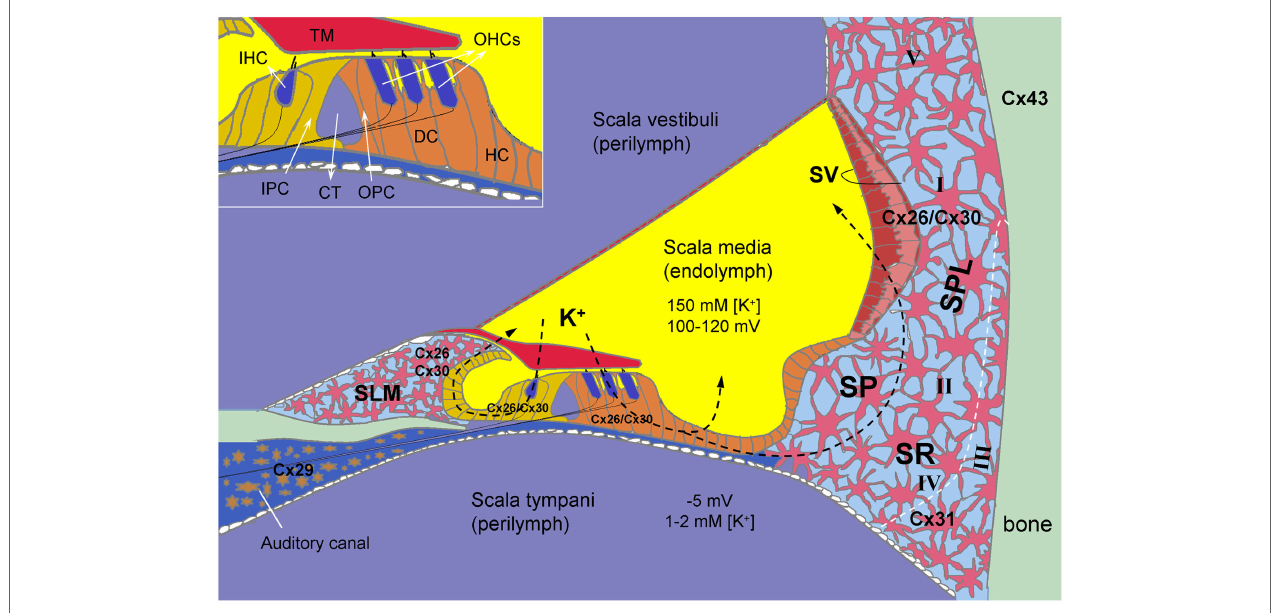
spiral ganglion neurons in the auditory canal. However, hair cells have no connexin expression. Inset: the organ of Corti. CT, cochlear tunnel; DC, Deiters cell; HC, Hensen cell; IHC, inner hair cell; IPC, inner pillar cell; OHCs, outer hair cells; OPC, outer pillar cell; TM, tectorial membrane; I–V, type I–V fibrocytes. Modified from Forge et al. (2003), Cohen-Salmon et al. (2004), Zhao and Yu (2006), and Liu and Zhao